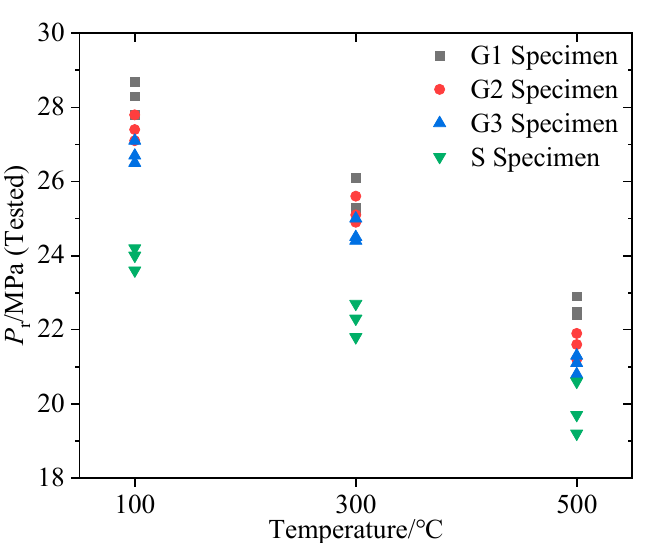
Figure 17. Variation of measured reopening pressure with specimen lithology and temperature.